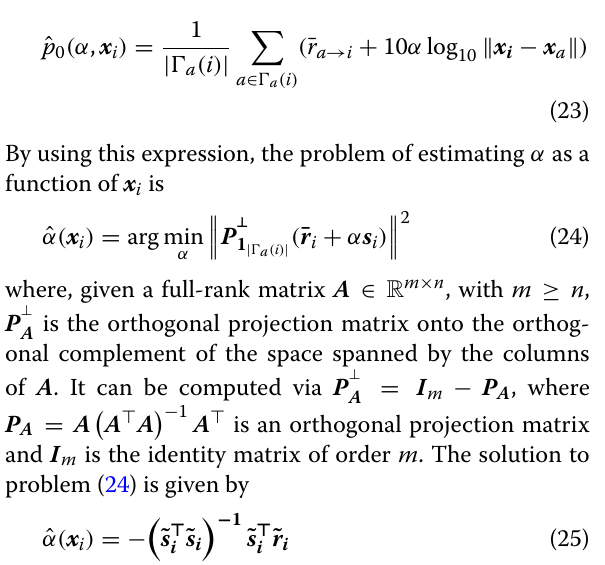
Algorithm 2 Distributed maximum likelihood